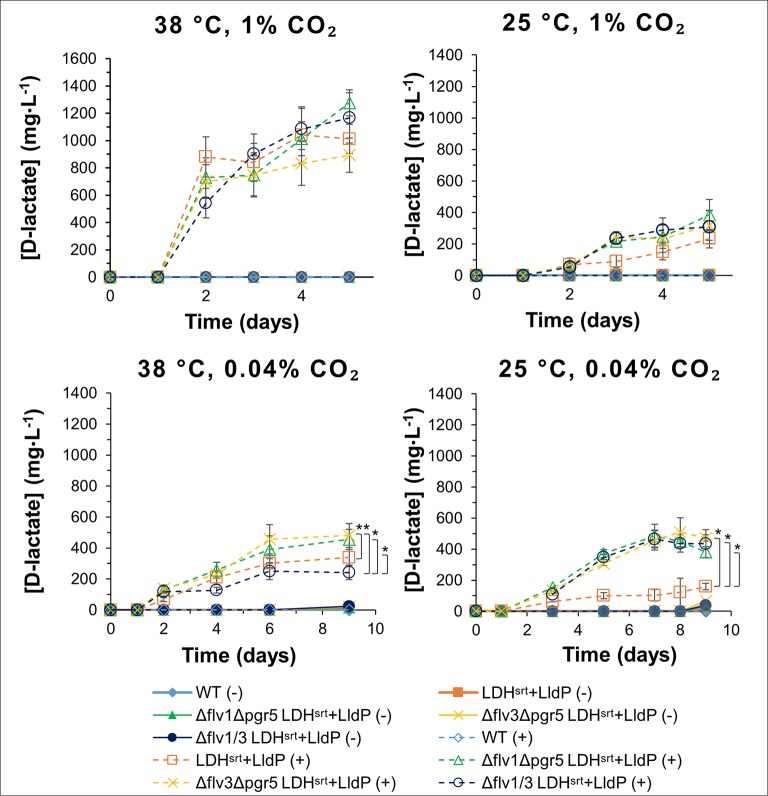
D-lactate production in several electron transport double mutants under different growth conditions. D-lactate concentrations in culture supernatants were measured at the time points indicated, in the absence (-) or presence (+) of 0.5 mM IPTG. Error bars indicate a 95% confidence interval based on the standard error of the mean for triplicate cultures. Asterisks denote statistically relevant differences between indicated strains.